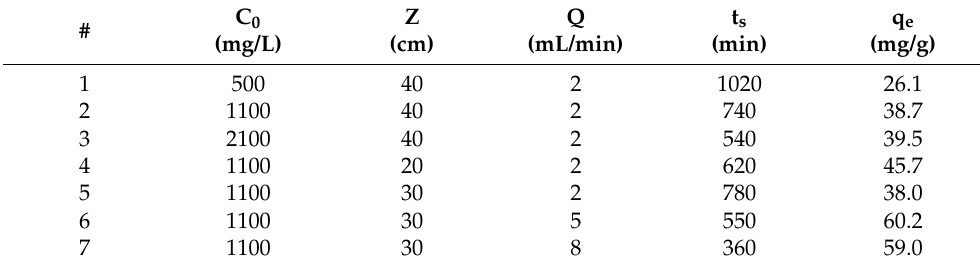
Figure 8. The effect of inlet flow rate on the adsorption of sulfate by WS60 in a fixed-bed column. Bed height, 30 cm; pH 5.2, with 0.03 M sodium acetate buffer; inlet sulfate concentration, 1100 mg/L. Table 3. Breakthrough parameters for the adsorption of sulfate onto WS60 under variable conditions, with pH 5.2 (sodium acetate buffer, 0.03 M).